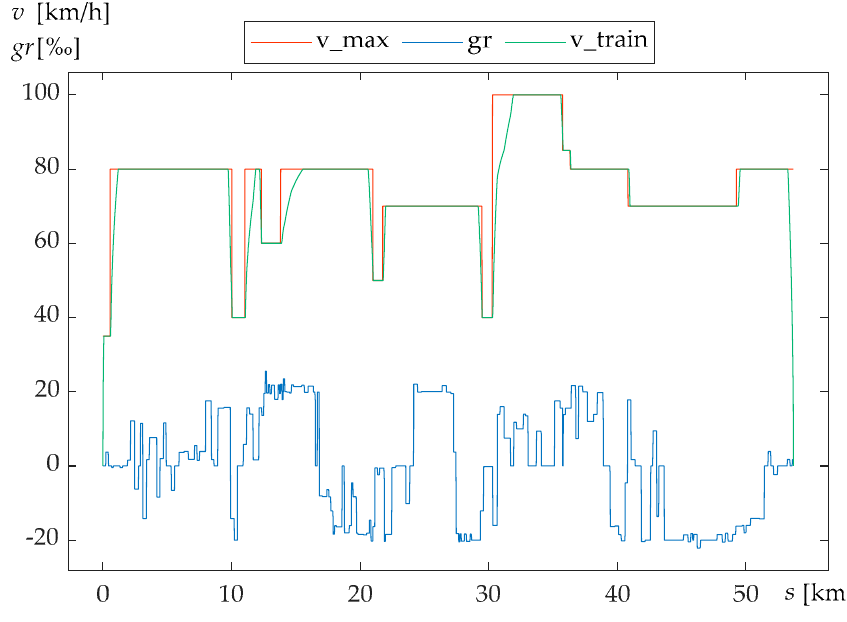
Figure 4. The railway profile. In Figure 5, red line represents power demand, and green line represents resistance force of the railway.